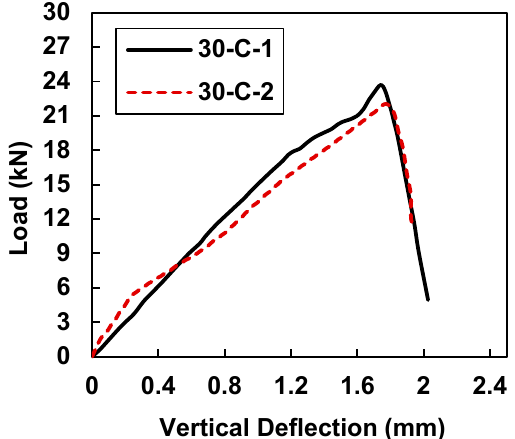
in the comparison to the control samples, an average increase of 132.19% was noted in the load-carrying capacity as well as an increase of 73.64% in the deflection. According to Table 5, the peak load and midspan deflection were 19.20 kN and 1.50 mm for sample 20-C-1, whereas sample 20-C-2 showed load and midspan deflection values of 20.04 kN and 1.667 mm. Figure 8 shows the maximum load and midspan deflection for samples 30-C-1 and 30-C-2.